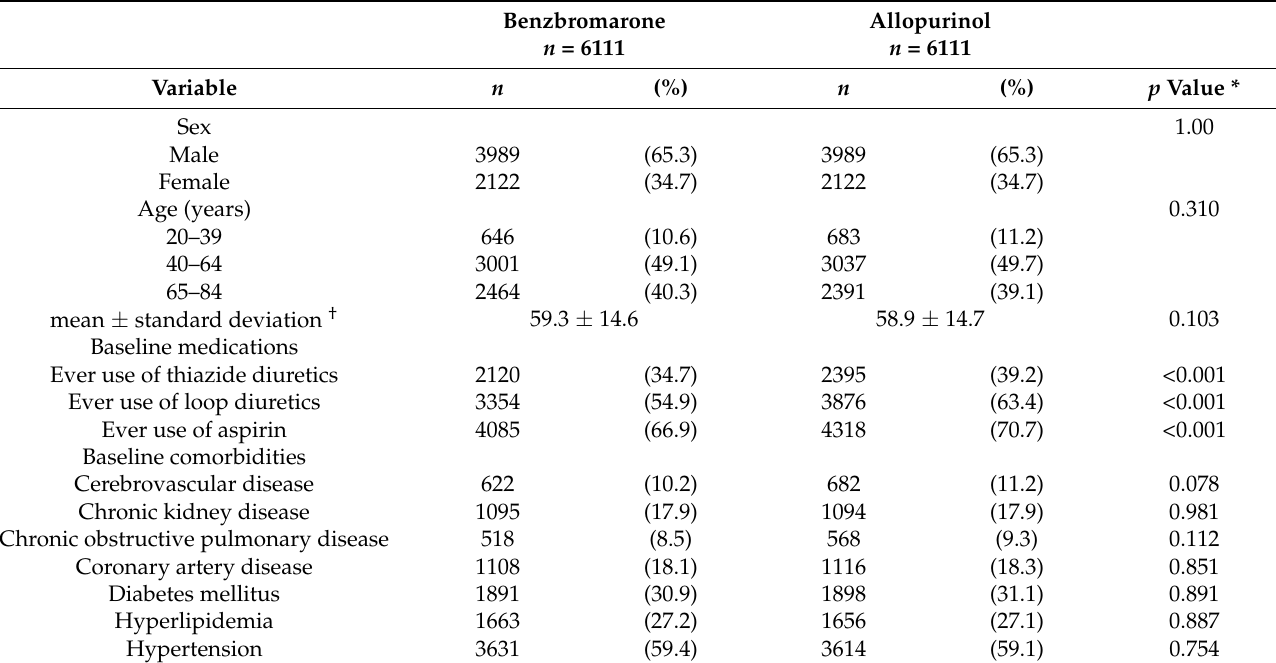
Table 1. Baseline information of the study subjects after propensity score